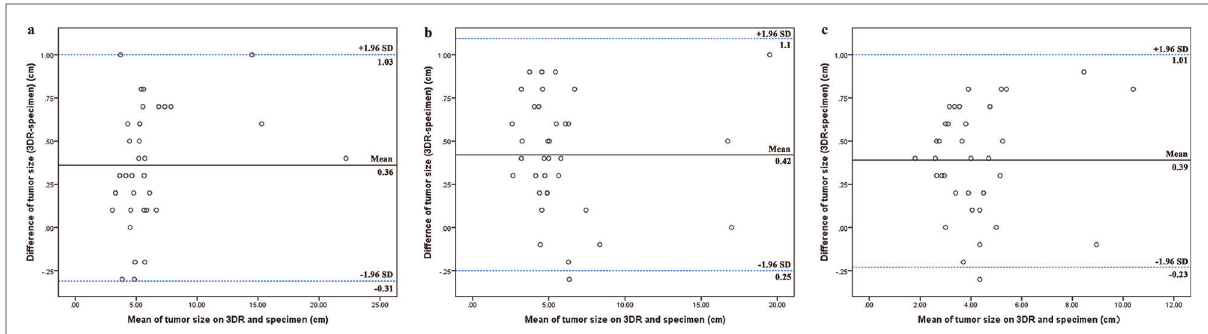
FIGURE 3 Correlation of tumor size between 3DR data and the specimens. The longest tumor diameters measured on 3DR in the horizontal orientation ( A ), the vertical orientation ( B ), and the saggital orientation ( C ) were compared to the corresponding distances in the pathological specimen. The Bland – Altman plot on each comparison demonstrated relatively high concordance rates within the 95% limits of agreement.